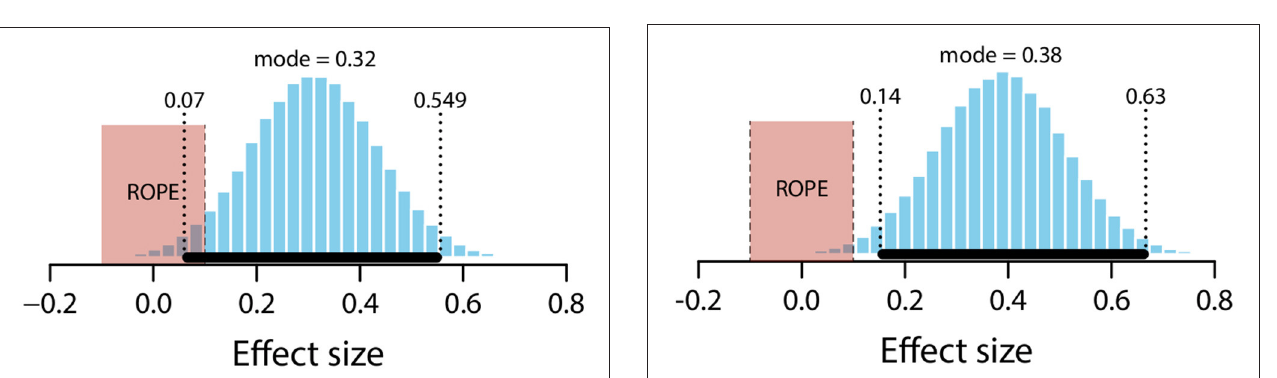
FIGURE 13 | Posterior distribution of effect size for difference between expected and unexpected conditions. ROPE from − 0.1 to 0.1. Black bar represents 95%